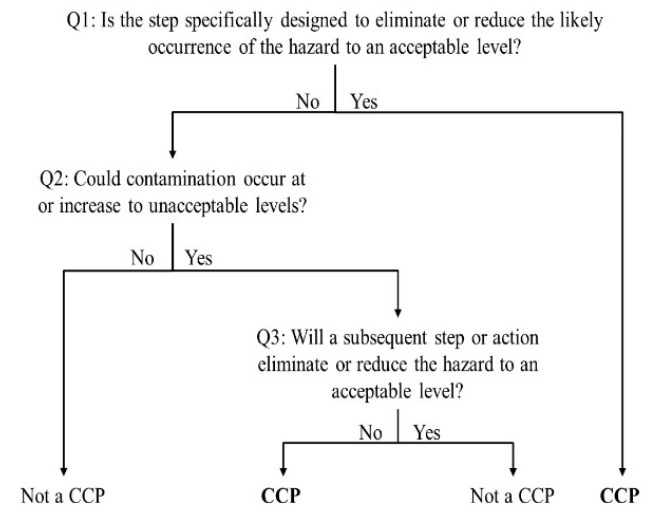
Figure 7. Decision tree for determining a critical control point (CCP) [12,26].